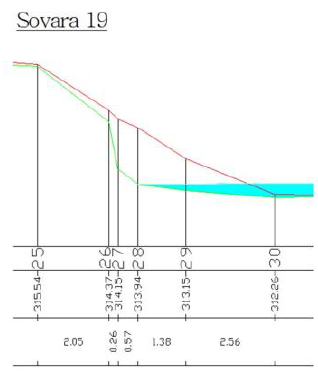
Figure 16. Example of artificial embankment slope - Land topographically detected in green and interpolated surface from